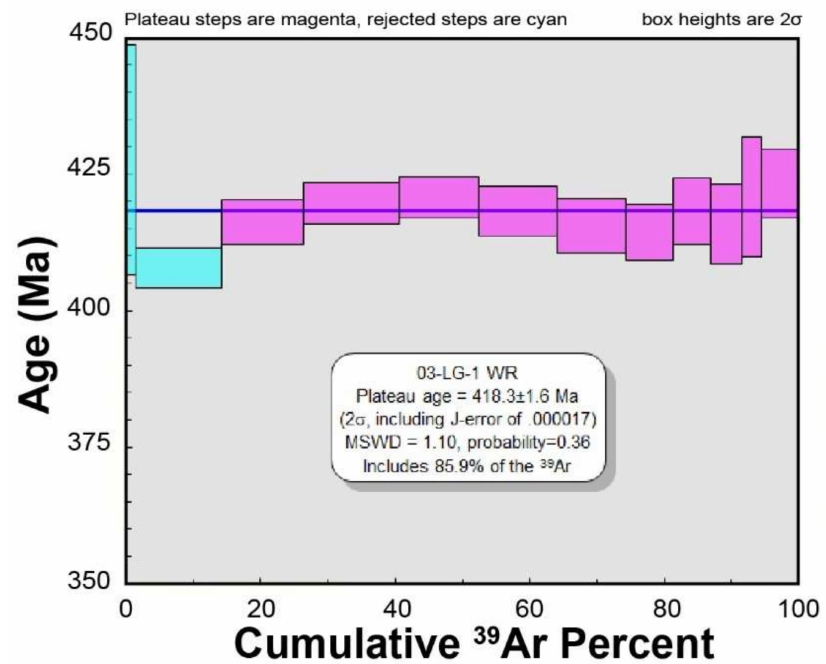
Figure 20. 40 Ar / 39 Ar age spectrum of whole-rock chips dominated by muscovite from the sericitic alteration surrounding gold-bearing quartz–carbonate veins from sample 03-LG-1.